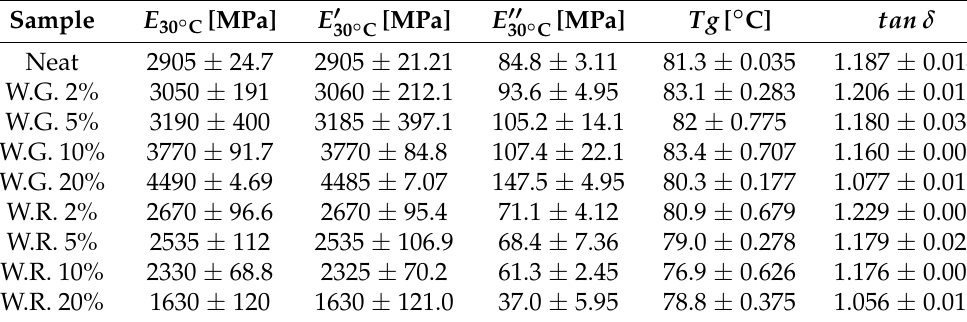
Table 3. DMTA Experimental results.